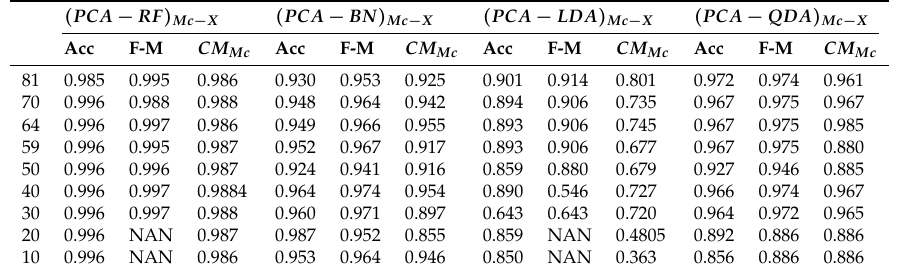
Table 10. Performance evaluation of the proposed framework in multi-class classification using PCA.